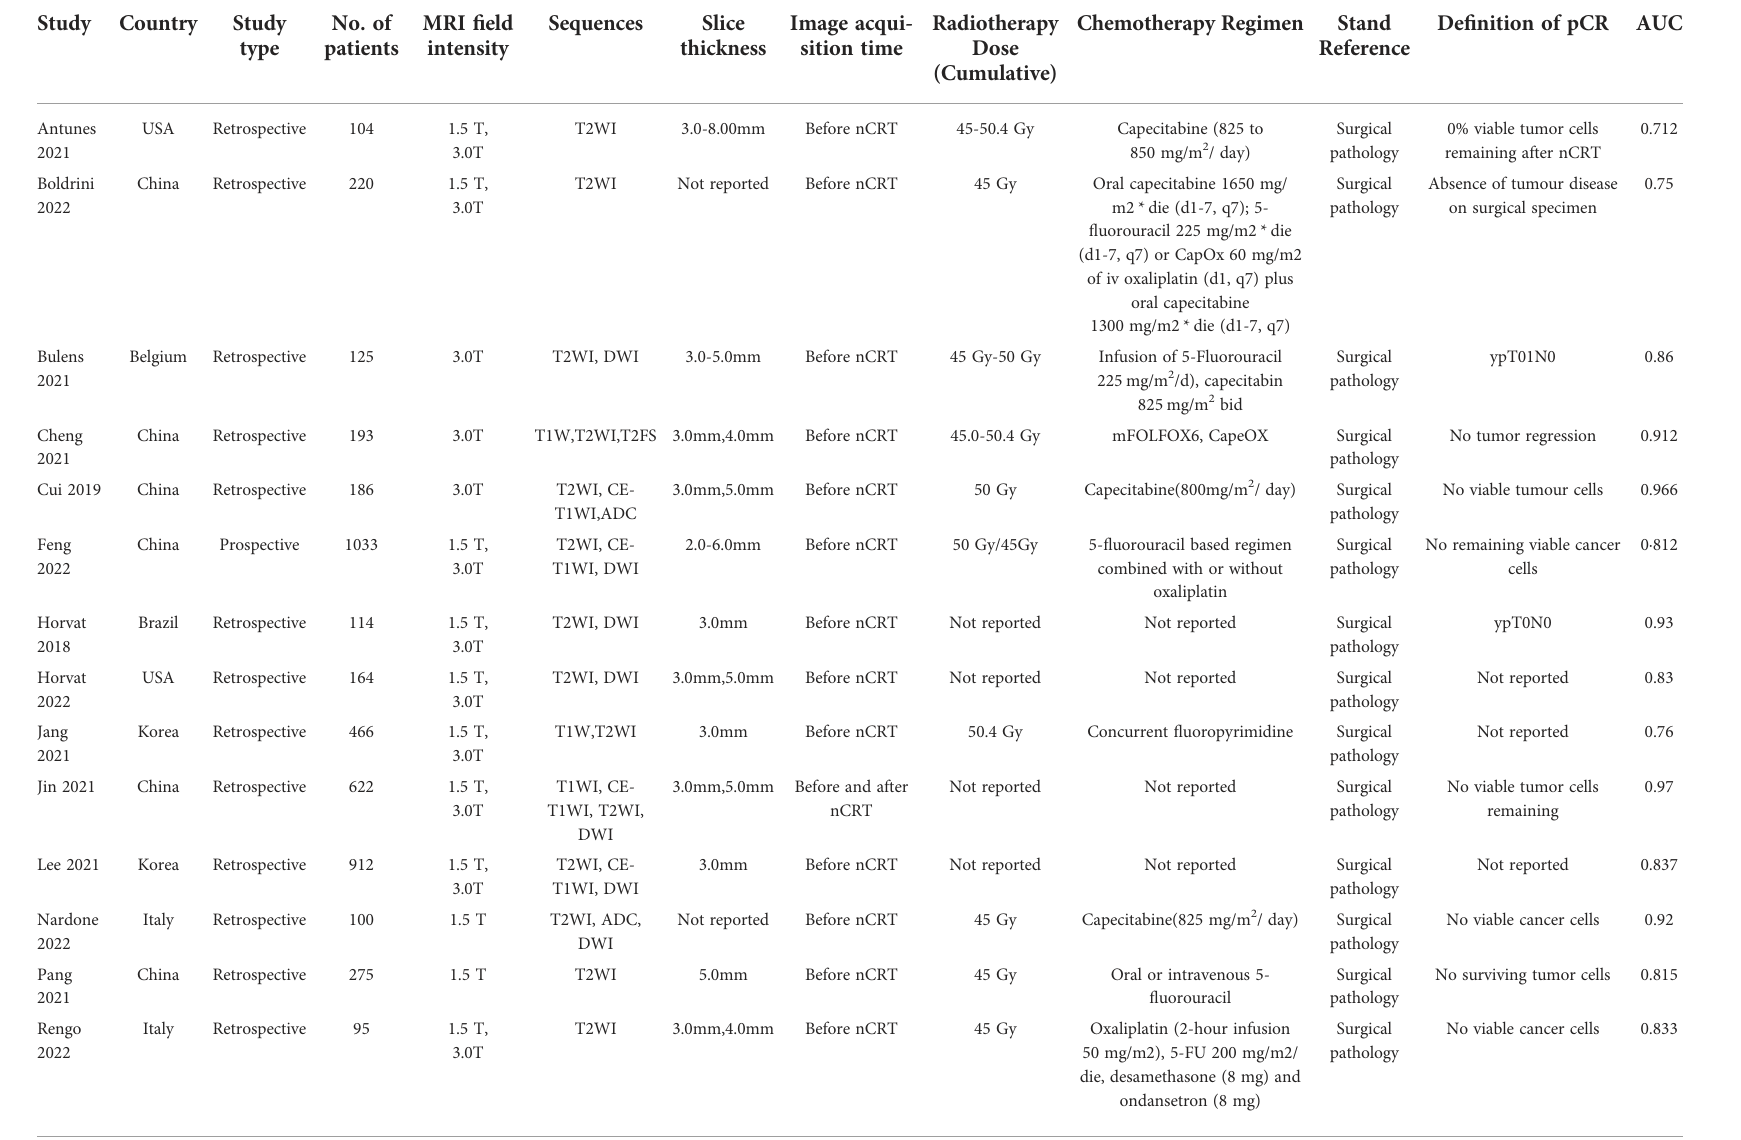
TABLE 1 Summary of general study